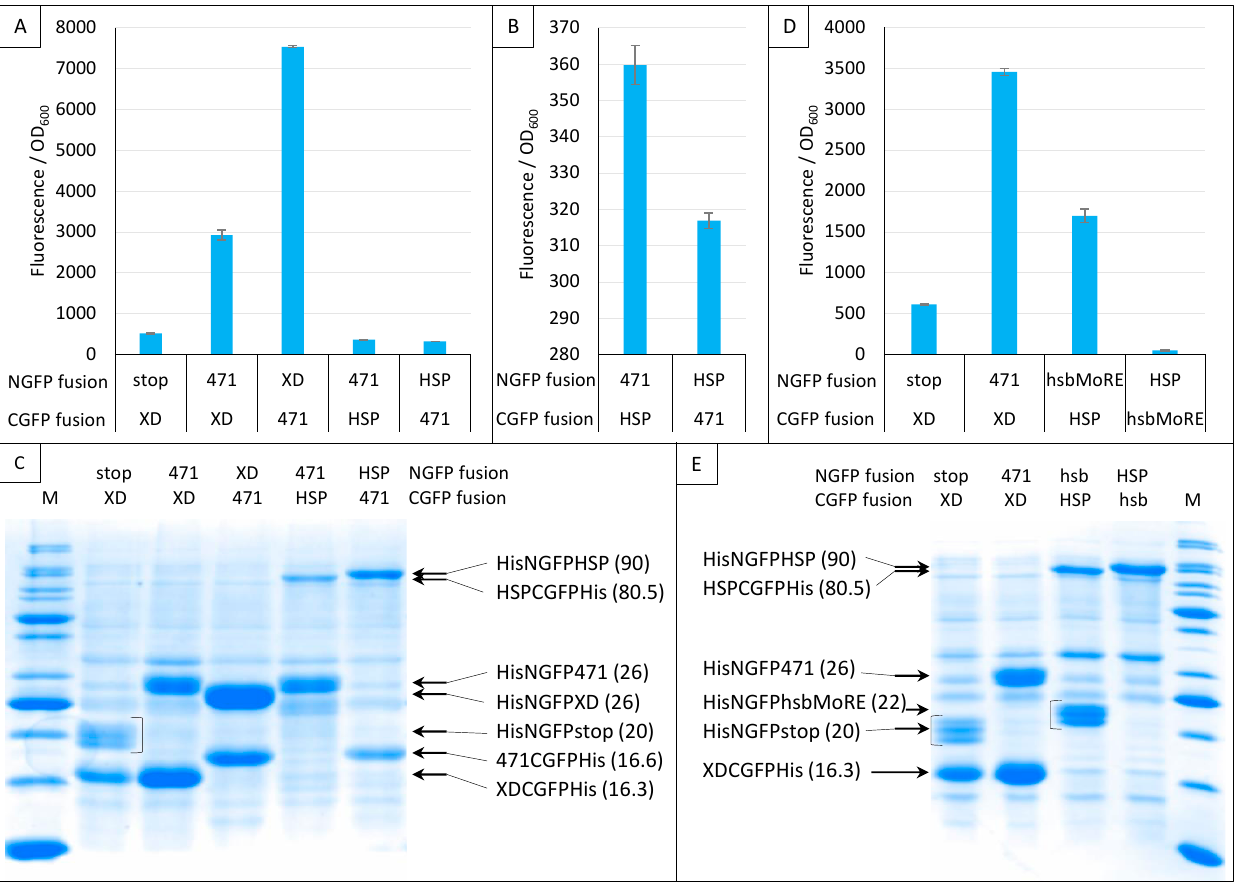
Figure 12. Swapping NGFP and CGFP fusions. Split-GFP reassembly assay results as obtained when swapping the proteins fused to NGFP and CGFP and with the sg100 GFP reporter at 17 °C for 24 h. In this experiment, CGFP fusions were also His-tagged. Fluorescence to OD 600 ratios obtained with 471 and XD or HSP ( A ), with 471 and HSP ( B ), with hsbMoRE and HSP ( D ) are shown. ( C ) SDS-PAGE analysis of the expression of the NGFP and CGFP fusions of A and B. ( E ) SDS-PAGE analysis of the expression of the NGFP and CGFP fusions of D. M, molecular size markers (200, 150, 100, 85, 70, 60, 50, 40, 30, 25, 20, 15, 10 kDa). In parentheses is indicated the molecular mass in kDa. Interestingly, the opposite result was obtained for the 471/HSP70 pair (Figure 12A,B): His-NGFP-471/HSP-CGFP-His provided more fluorescence than His-NGFP-HSP/471- CGFP-His, suggesting that the behavior of the same protein (471) toward a given interaction partner (HSP70) cannot be reliably anticipated from its behavior toward another one (XD). A similar observation was also reported by [15] using the frGFP variant. In that case, while the NfrGFP-BARD1/BRCA1-CfrGFP pair yielded a detectable fluorescence, the NfrGFP- BRCA1/BARD1-CfrGFP pair did not. Interestingly, in that study, no fluorescence was detected when sg100 was used instead of fr, whatever the combination of fusions used, suggesting that the choice between different GFP variants might be protein pair dependent. Likewise, ref. [37] also reported that while a combination made of either the helical domain (HD) or the first oligonucleotide/oligosaccharide binding fold (OB1) of BRCA2 fused to NfrGFP is able to interact with the intrinsically disordered peptide DSS1 fused to CfrGFP and to generate fluorescence, the opposite combination (NfrGFP-DSS1/HD-CfrGFP